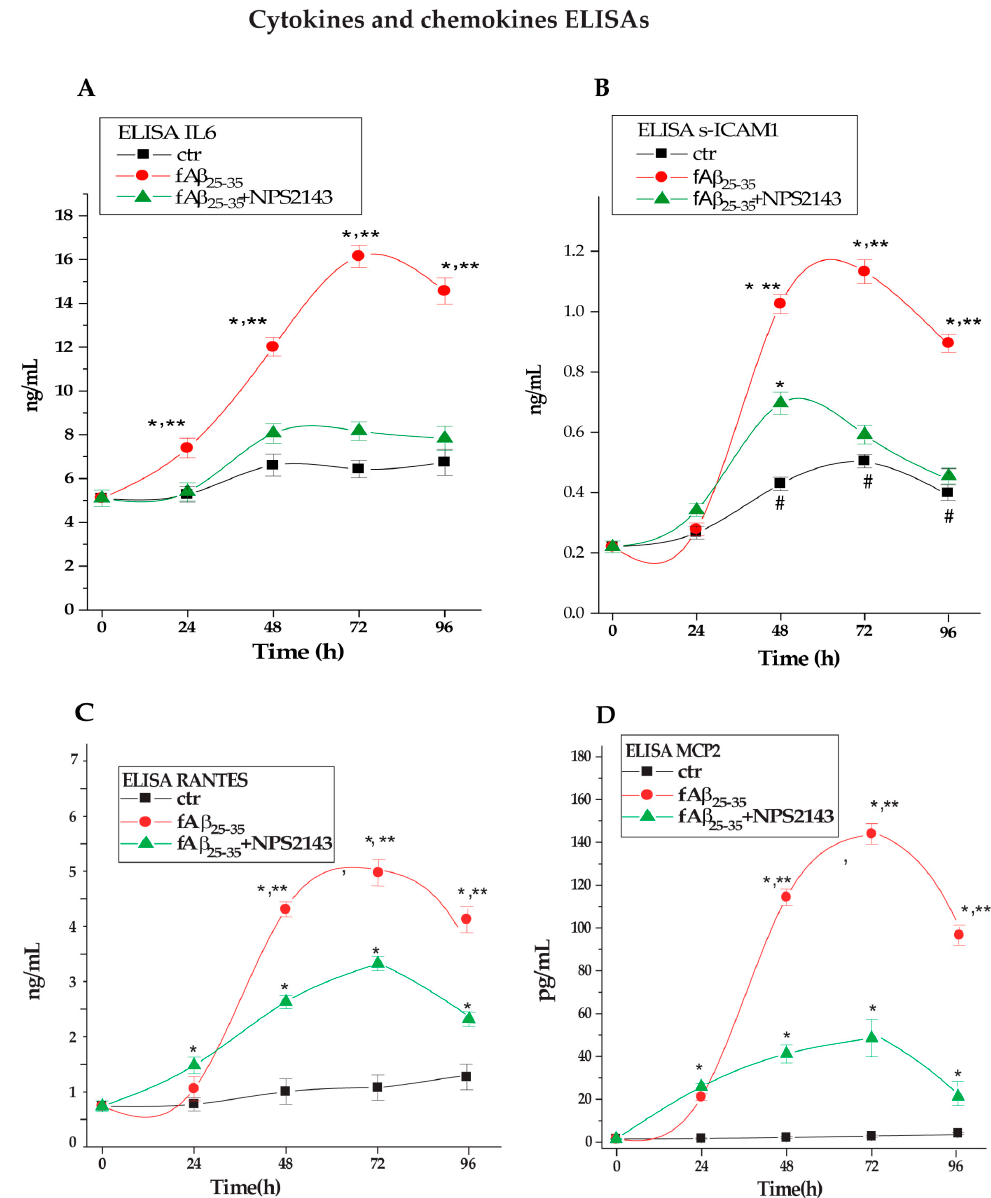
Figure 3. Changes in released levels of ( A ) IL-6, ( B ) s-ICAM-1, ( C ) RANTES, and ( D ) MCP-2 in NAHAs treated with fA β 25–35 ± NPS 2143 vs. untreated controls (CTR). Each agent was assessed in the NAHA-conditioned media via a specific ELISA kit as detailed in the Materials and Methods. Points on the curves are means ± SEMs of 3–5 independent experiments, each carried out in duplicate. One-way ANOVA followed by post hoc Tukey’s test allowed us to calculate p values. * p < 0.05 vs. time-corresponding CTR values; # p < 0.05 vs. 0-h CTR value; ** p < 0.05 vs. fA β 25–35 + NPS 2143 values.